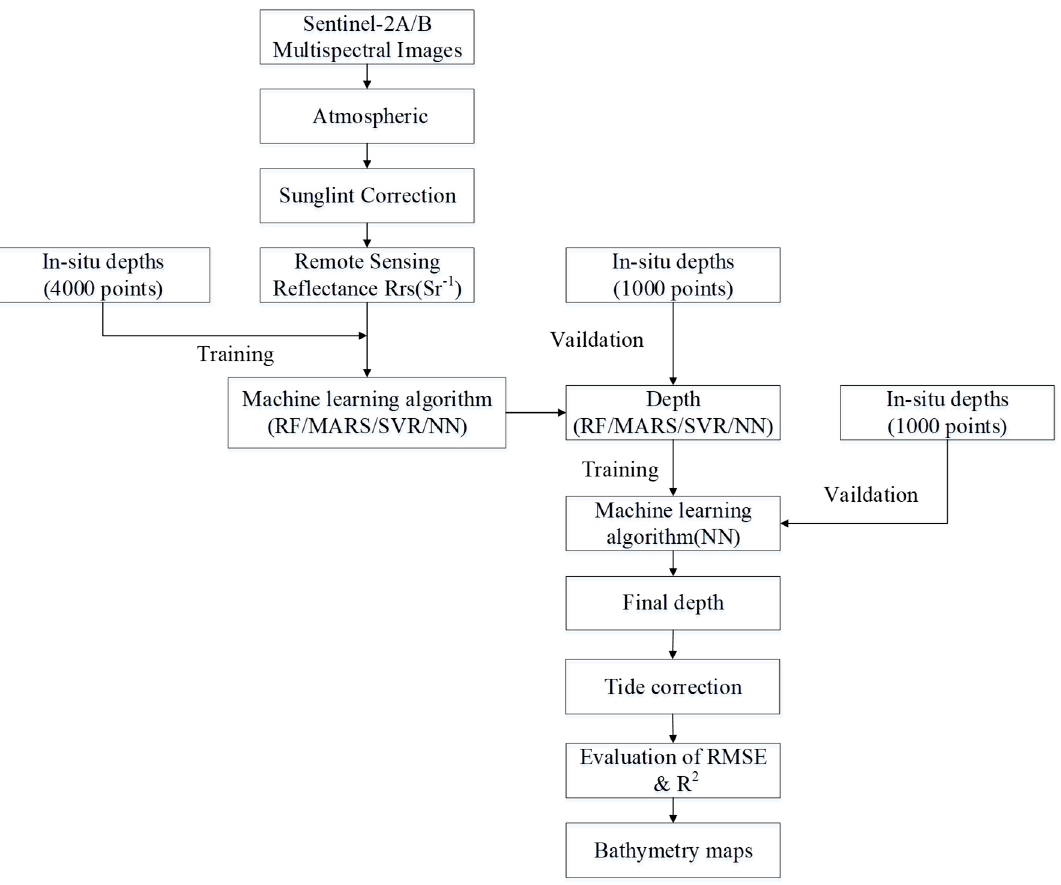
Figure 1. The general workflow of the proposed system for water depth estimation from satellite images.